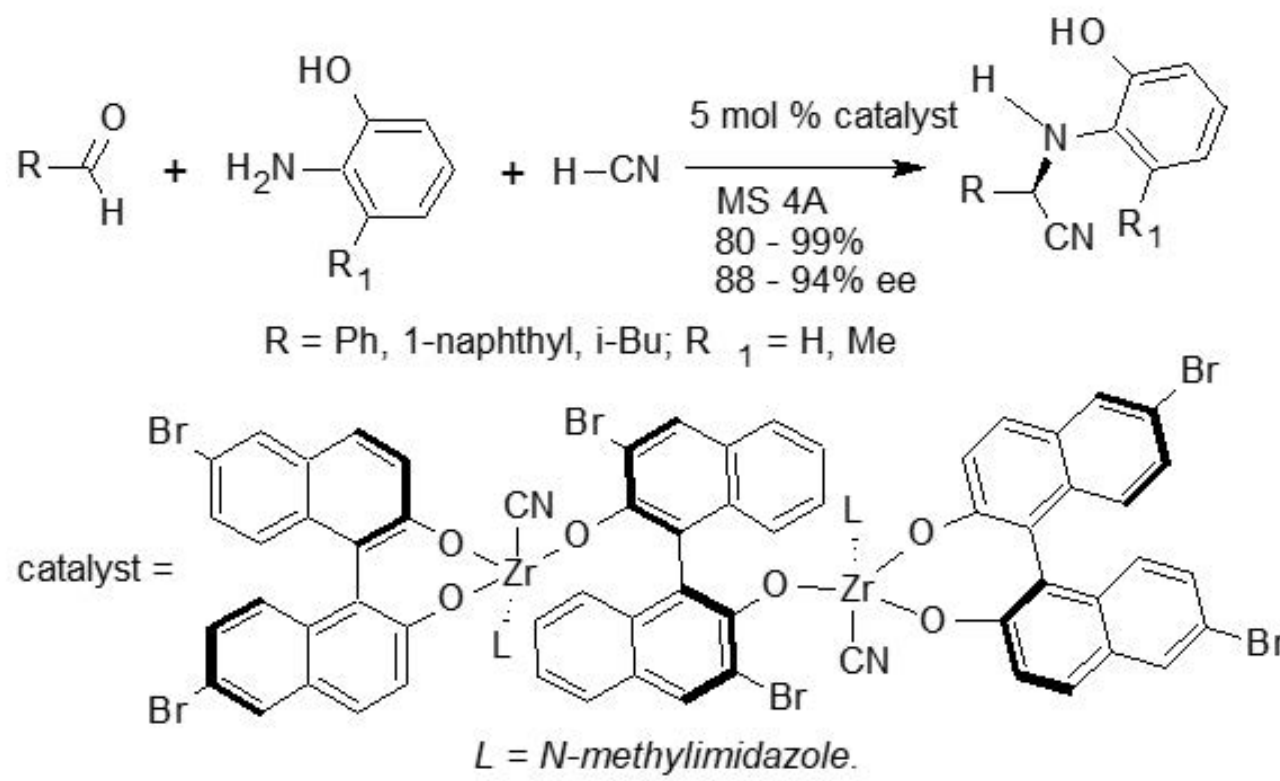
Scheme 13. Asymmetric Strecker synthesis mediated by Kobayashi’s